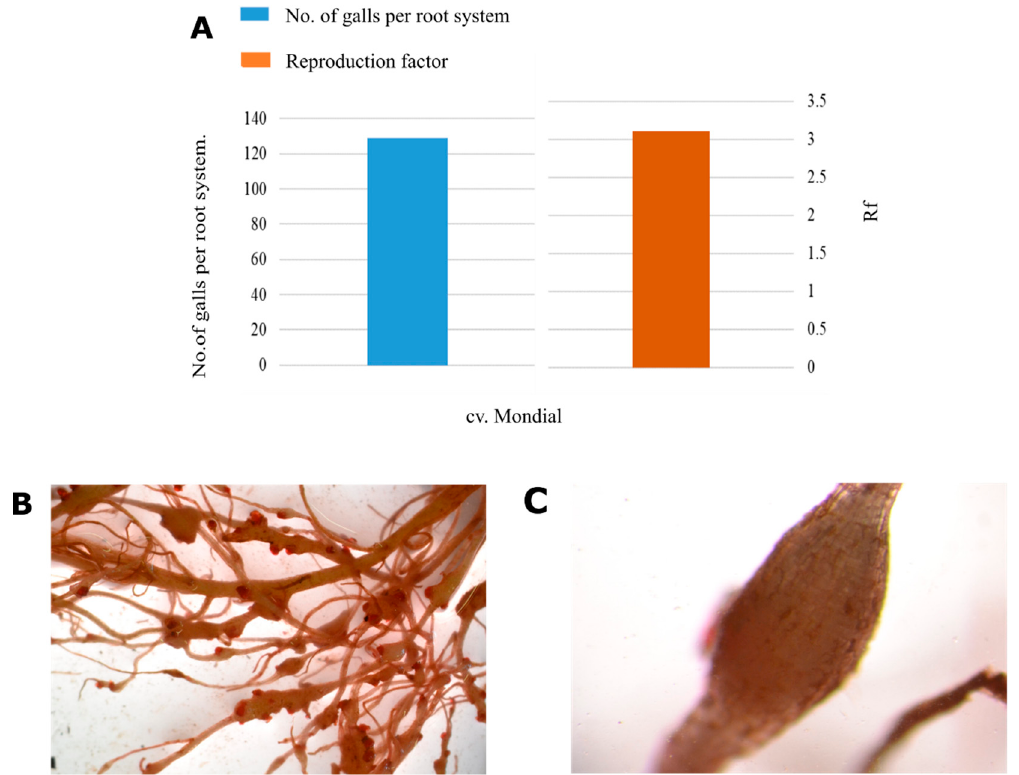
Figure 1. Responses of Solanum tuberosum cv. Mondial potato cultivar to Meloidogyne javanica infestation. ( A ) Reproductive factor and the number of galls induced by Meloidogyne javanica ( B ) and ( C ) displays nematode damage on potato roots, the egg masses stained pink and a mature gall, respectively.